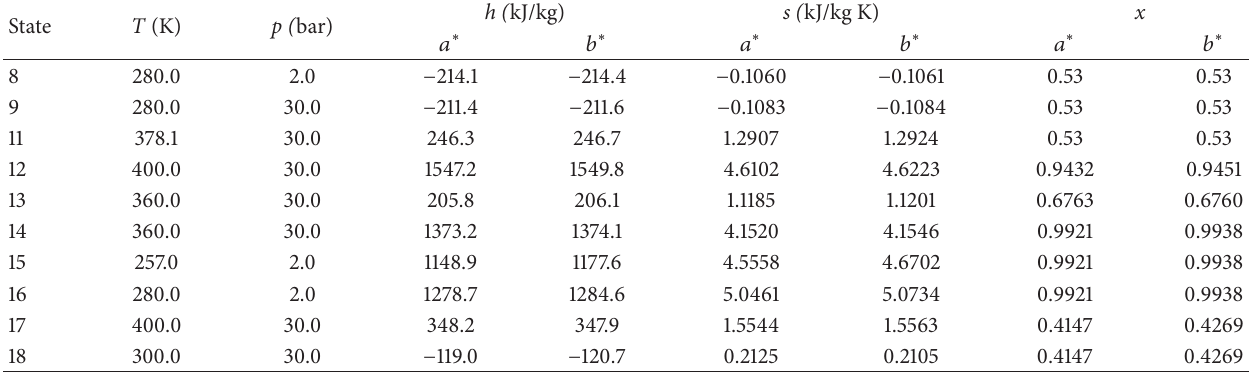
Table 2: Comparison between the properties of the present work and those from the published literature [17]. State